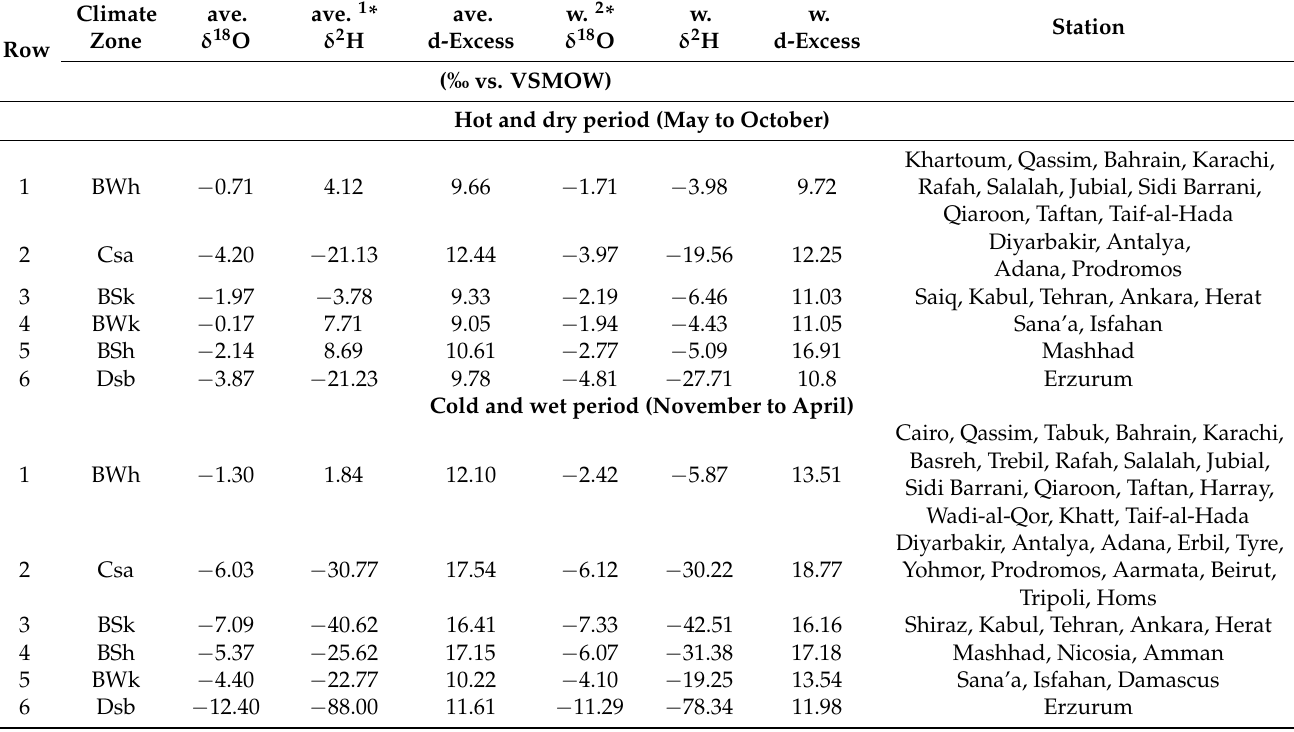
Table 2. The average stable isotope values in the studied stations based on the Köppen climate zones. Climate Row